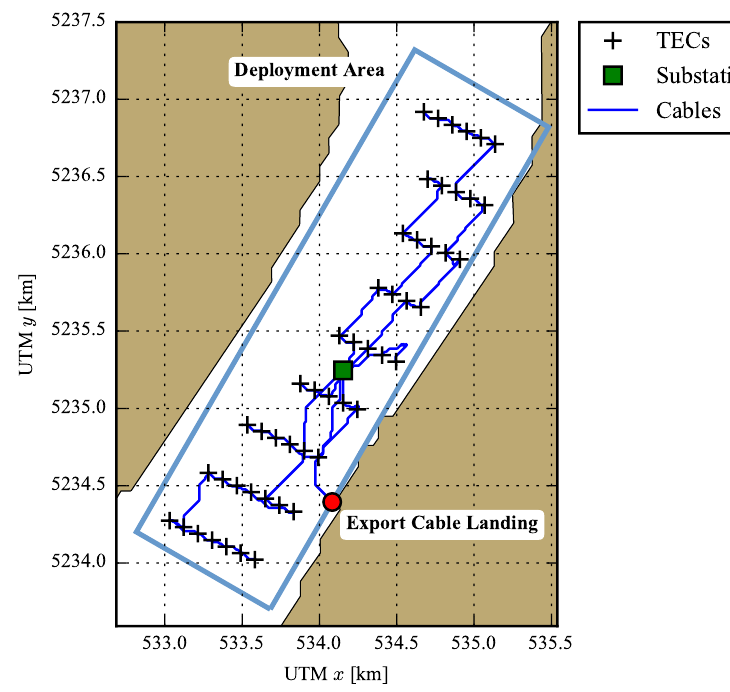
Figure 14. 50 TEC DTOcean simulation array layout and electrical network.